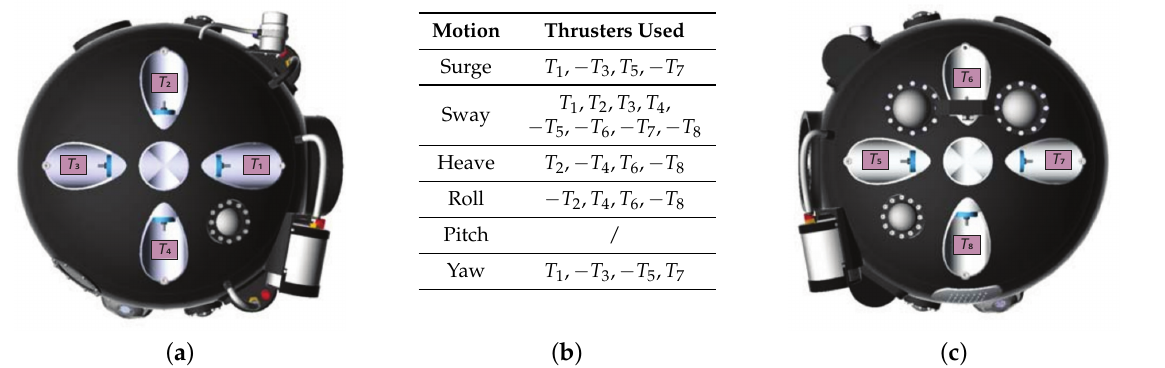
Figure 2. 3D model of UX-1 robot and its thruster configuration. ( a ) Right view. ( b ) Thruster configuration. ( c ) Left